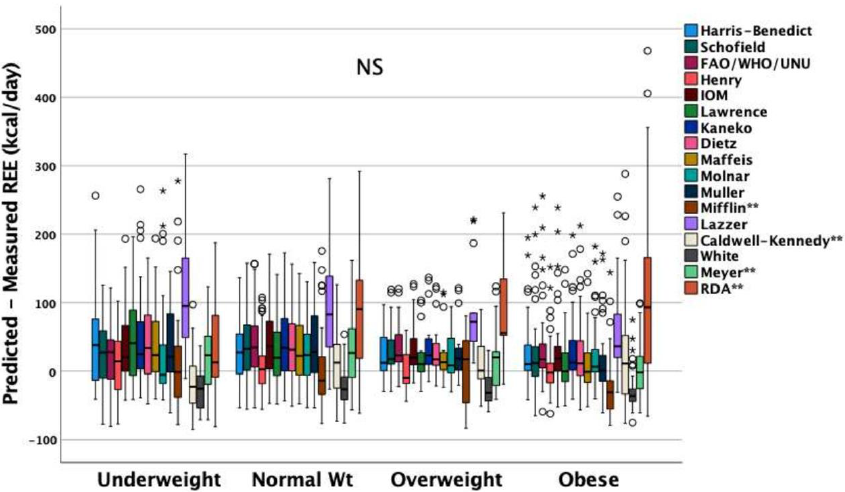
Figure 4. Paired estimated by predicted equations’ resting energy expenditure (eREE) and REE measured by IC (REE IC ) differences did not differ among malnutrition groups for most predicted equations, apart from the Mifflin ( p = 0.016), Caldwell–Kennedy ( p = 0.039), Meyer ( p = 0.042), and RDA ( p < 0.01) equations. The bold black line in box plots indicates the median per group, the bottom of the box indicates the 25 th percentile and the top of the box represents the 75 th percentile; the T-bars (whiskers) and horizontal lines show minimum and maximum values of the calculated non- outlier values; circles are the outliers, asterisks are the extreme outliers.